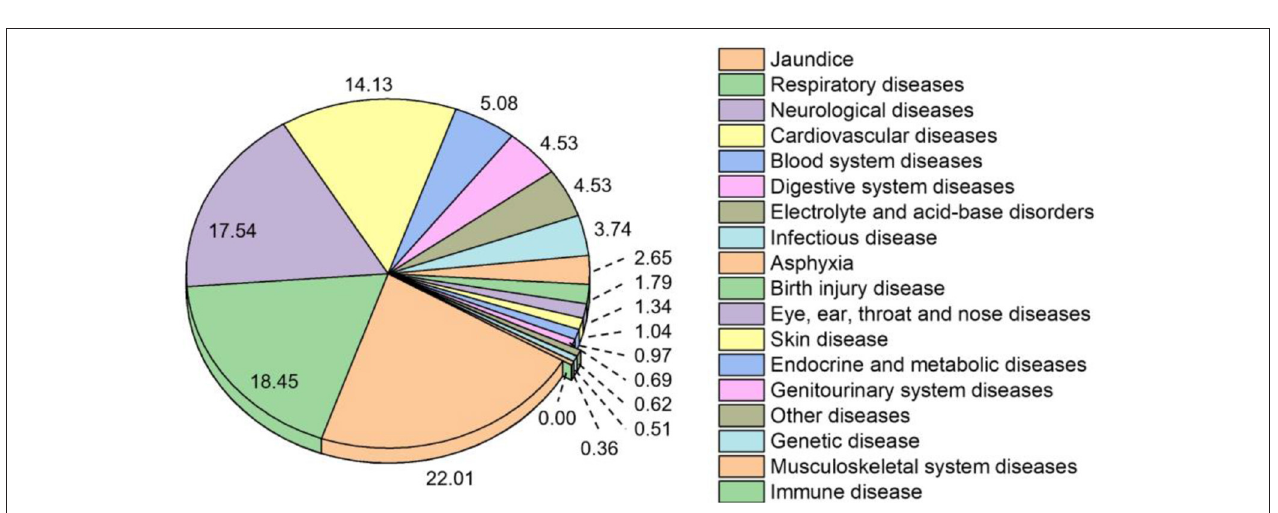
FIGURE 6 | Disease spectrum of infants in the NICU over the study period via ICD-10. Note: The prevalence of neonatal disease is expressed as a percentage (%) of all reported diseases.